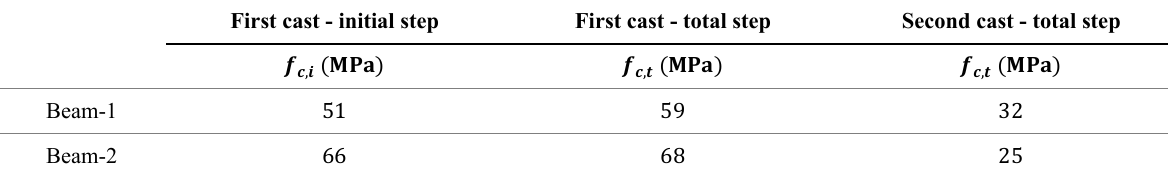
Table 1. Strength of the cylindrical specimens at different ages.